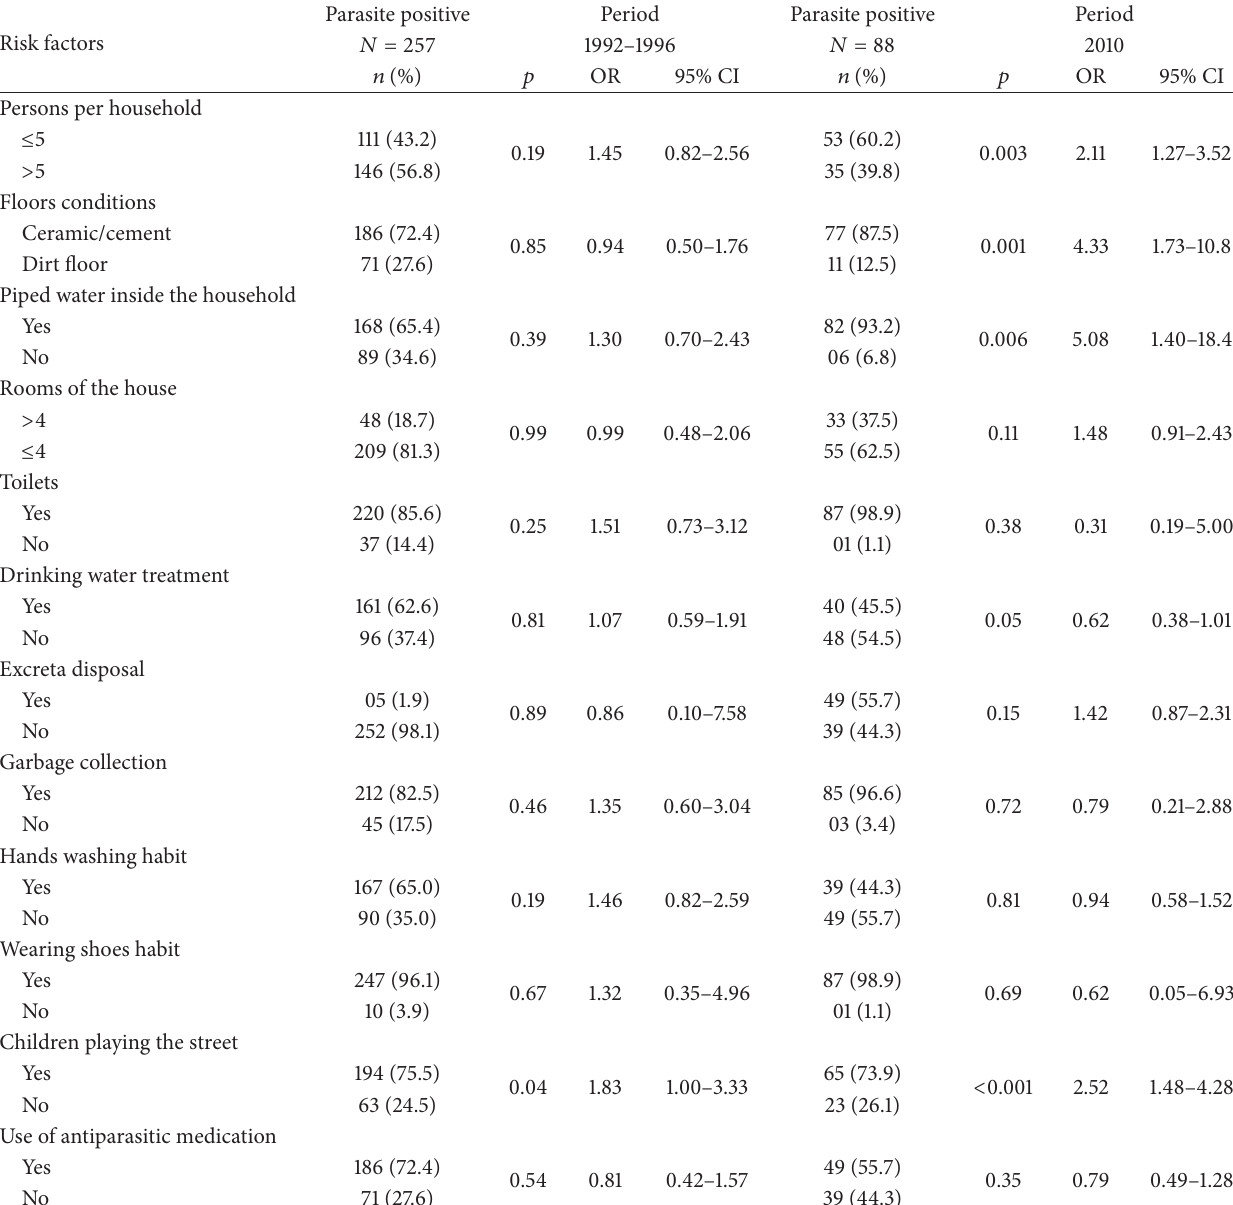
Table 3: Univariate analyses of intestinal parasitic infections and potential risk factors in the period 1992–1996 and in 2010, Northwest